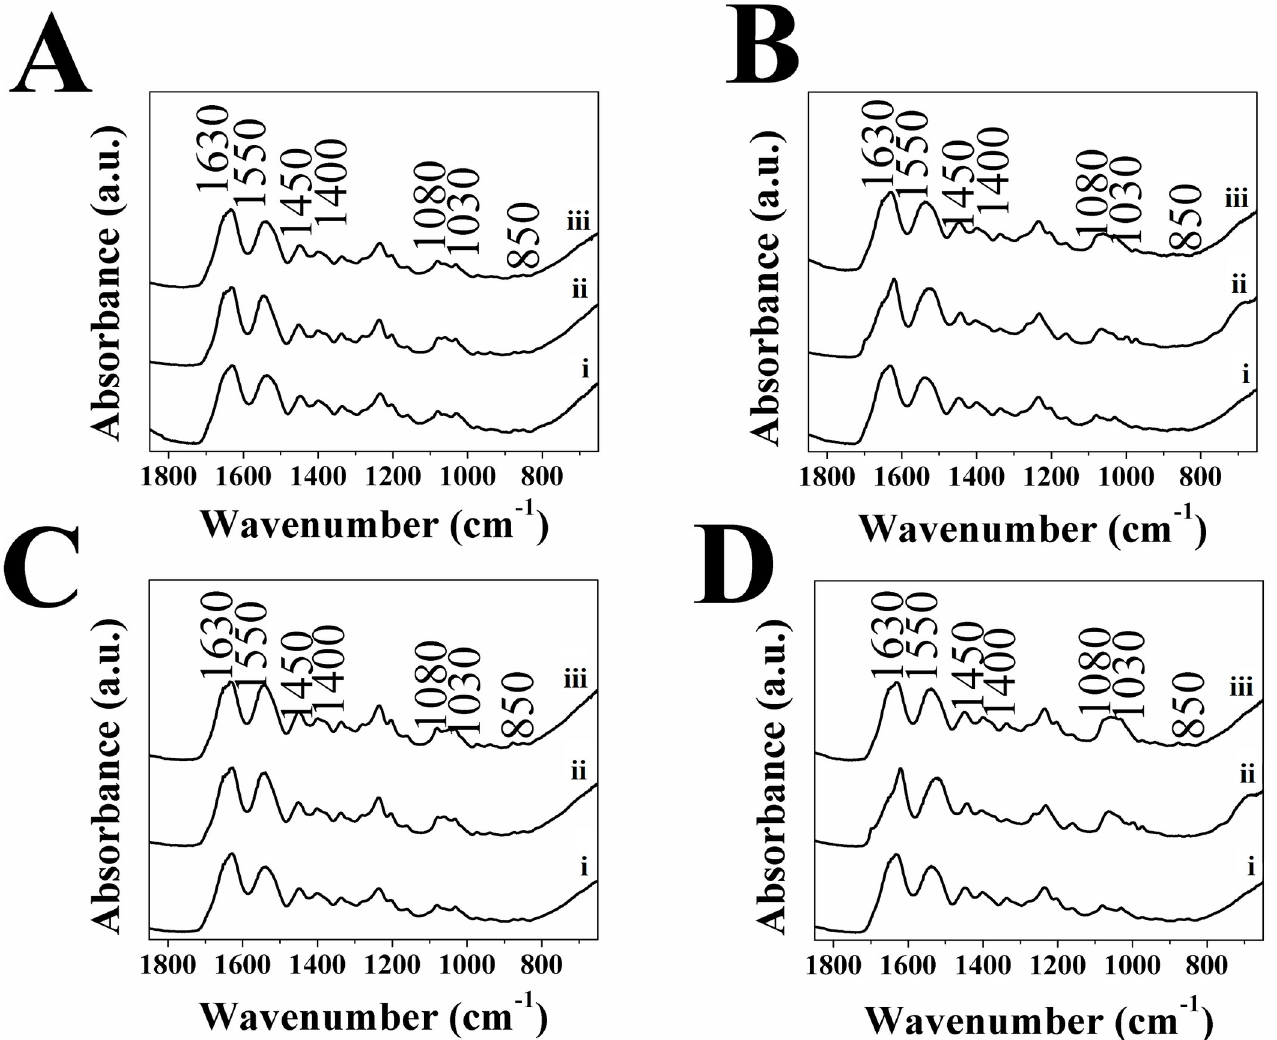
Fig 9. ATR-FTIR for A) 1:1 DC-C s , B) 1:1 DC-C p , C) 1:2 DC-C s and D) 1:2 DC-C p , i) as-made and immersed in SBF for ii) 3 and iii) 7 days.